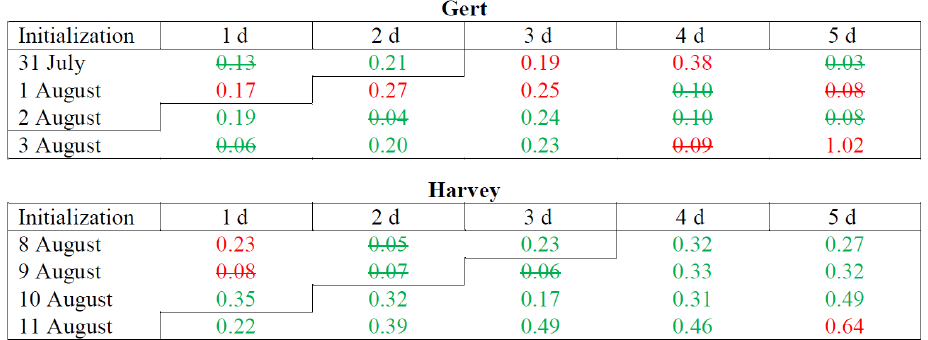
Table 1. RMSE (root mean square error) relative differences in the 1000–500hPa relative vorticity between the AER and CTL forecasts for the AEWs that developed Gert and Harvey. For each forecast day, the relative differences are calculated by taking (AER–CTL)/CTL of the RMSEs over the region following the AEWs (see the text for more details). The green values indicate the AER improved the forecast, while red values indicate the AER degraded the forecast; crossed-out values were not significant to the 99% confidence interval. The staircase border in each case separates times when the waves are located onshore (upper left) and offshore (lower